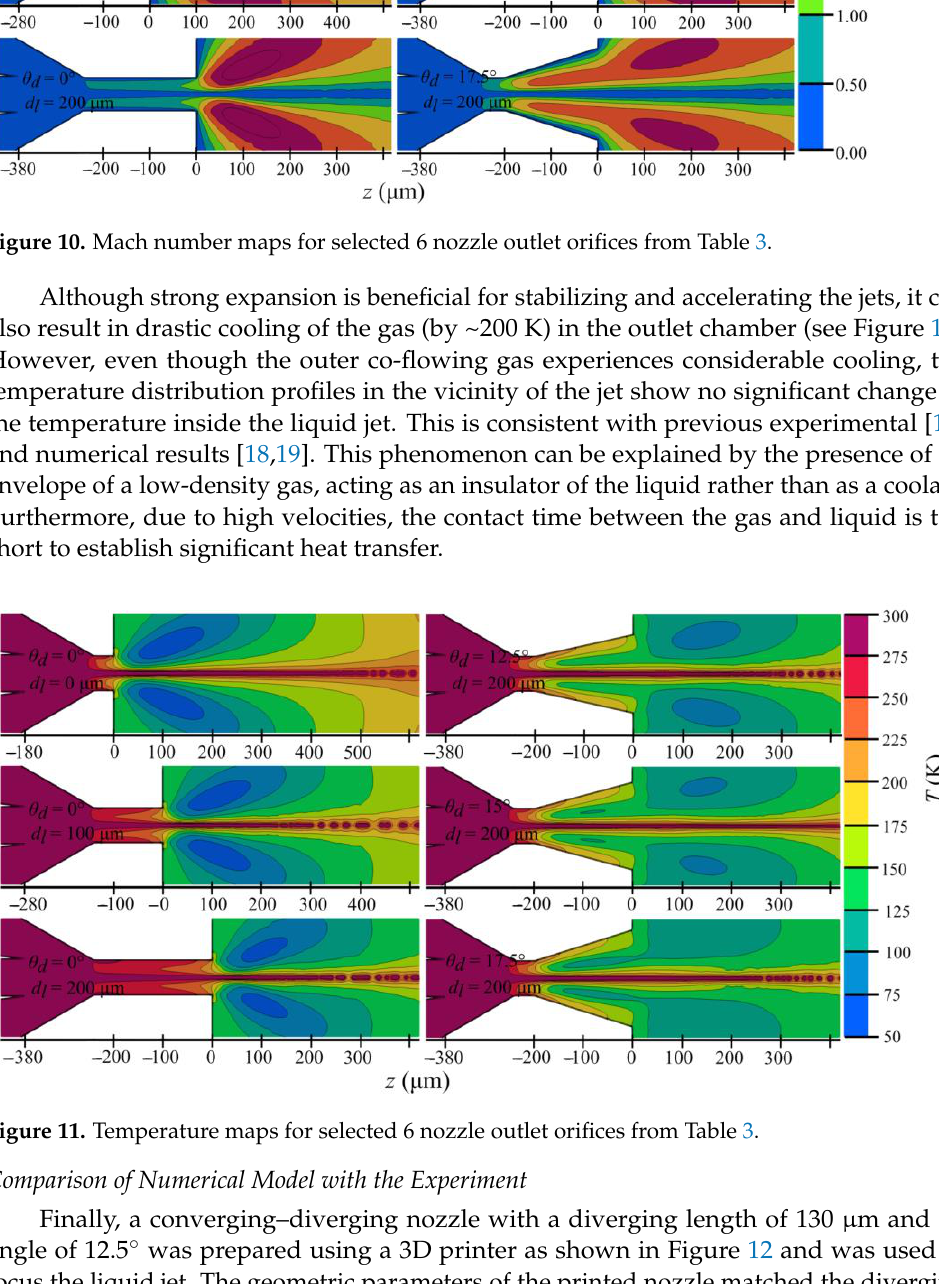
Figure 11. Temperature maps for selected 6 nozzle outlet orifices from Table